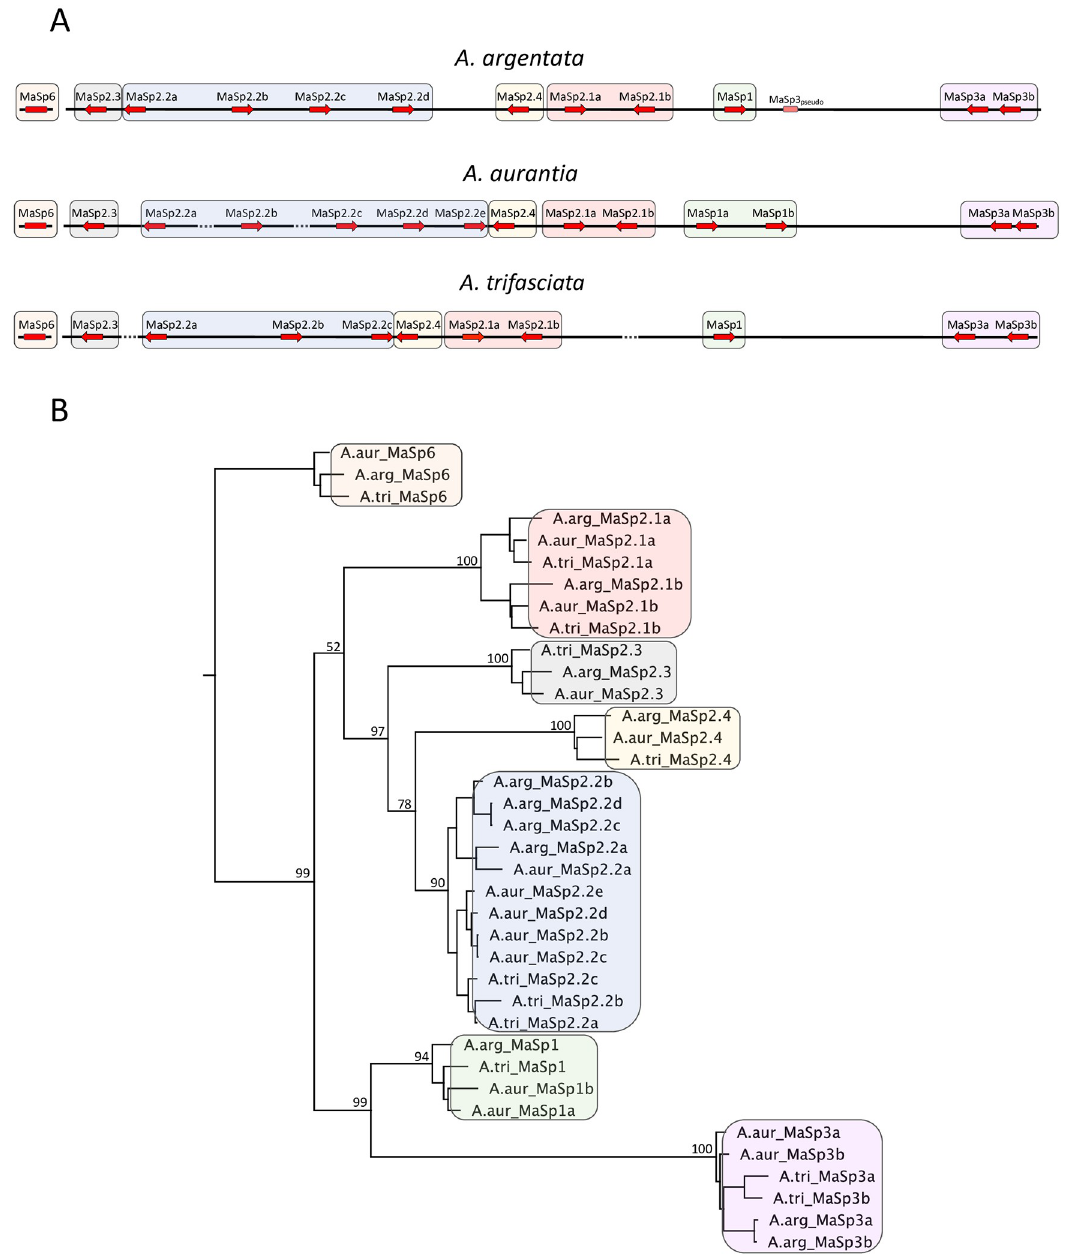
Fig 1. Organization and phylogenetic relationships of MaSp genes in Argiope . A) Schematic depiction of the genomic cluster containing most of the MaSp paralogs in each Argiope species (MaSp6 is located in a separate region in each species). The relative directionality of transcription is indicated by arrows. Dotted line regions between genes indicate gaps in the assembly where there is no direct support for contiguity between genes. The size of the cluster differs for each species and is approximately 1–1.5 Mb in size (see S1 Fig for additional details). The numbers associated with each MaSp gene name reflect putative homology relationships, while the letters reflect genomic location within each group. B) Phylogenetic relationships among all gene copies based on the concatenated N- and C-terminal nucleotide sequences for each gene. Bootstrap values provided for nodes defining relationships among primary MaSp clades. The tree was rooted with MaSp6 because this gene is not a member of the MaSp cluster.